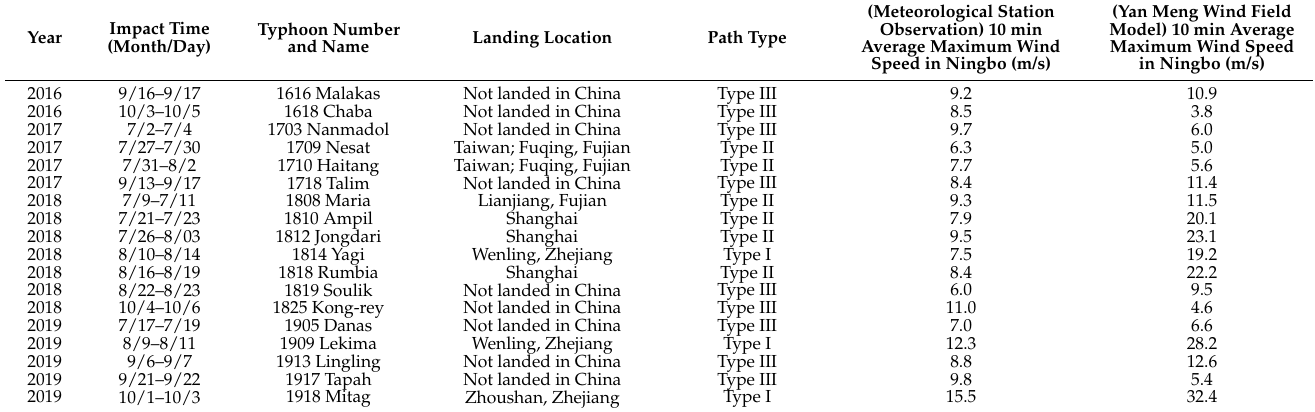
Figure 7. Insured loss rate of townships due to type II typhoons. ( a ) 1410 Matmo; ( b ) 1614 Meranti; ( c ) 1808 Maria. Figure 8. Insured loss rate of townships due to type III typhoons. ( a ) 1616 Malakas; ( b ) 1618 Chaba; ( c ) 1718 Talim. A summary of the underwriting data and claims data due to typhoons from 2014- 2019 according to district and county scales (as shown in Table 2) showed that the 6-year total coverage varied widely among districts and counties, and the total coverage was significantly higher in Cixi than in other districts and counties due to the largest popula- tion base. The zoning map of Ningbo districts and counties is shown in Figure 9. As can be seen from Table 2, Yuyao, Xiangshan, Ninghai, and Cixi had a higher total payout amount, and Xiangshan, Beilun, Ninghai, Yuyao had larger insured loss rates. It is worth